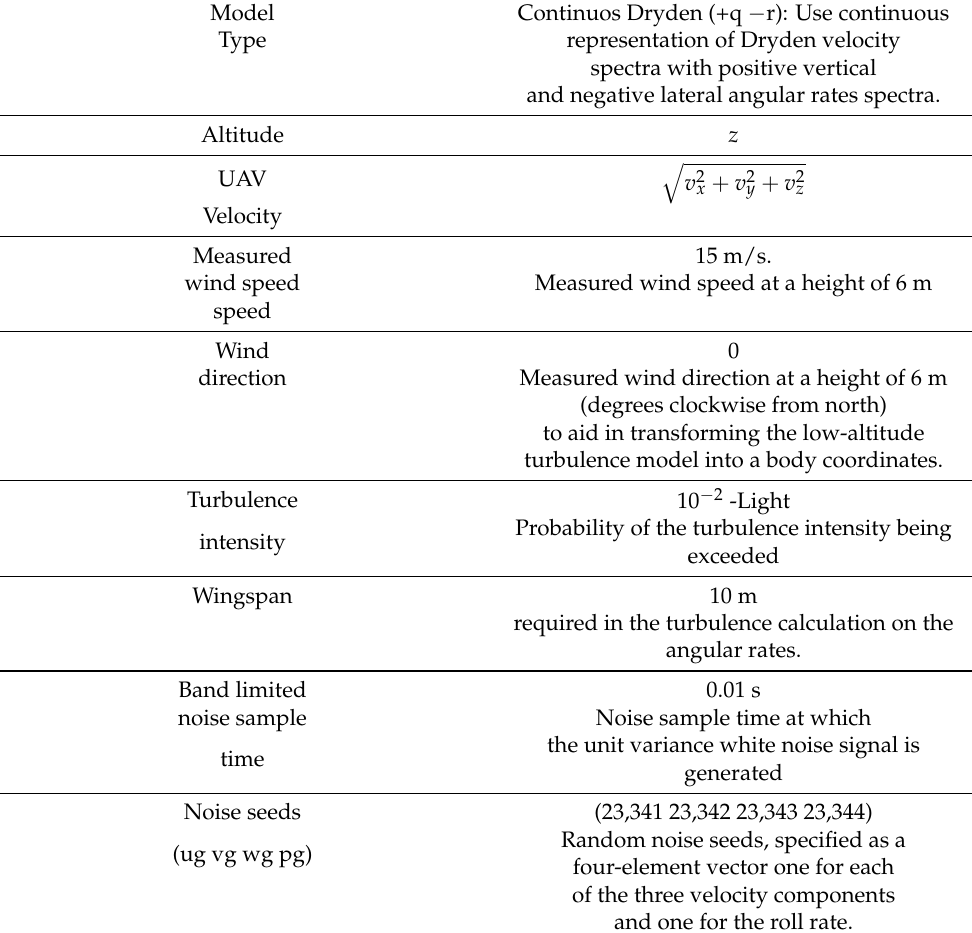
Table 2. Dryden Wind Turbulence Model Parameters.